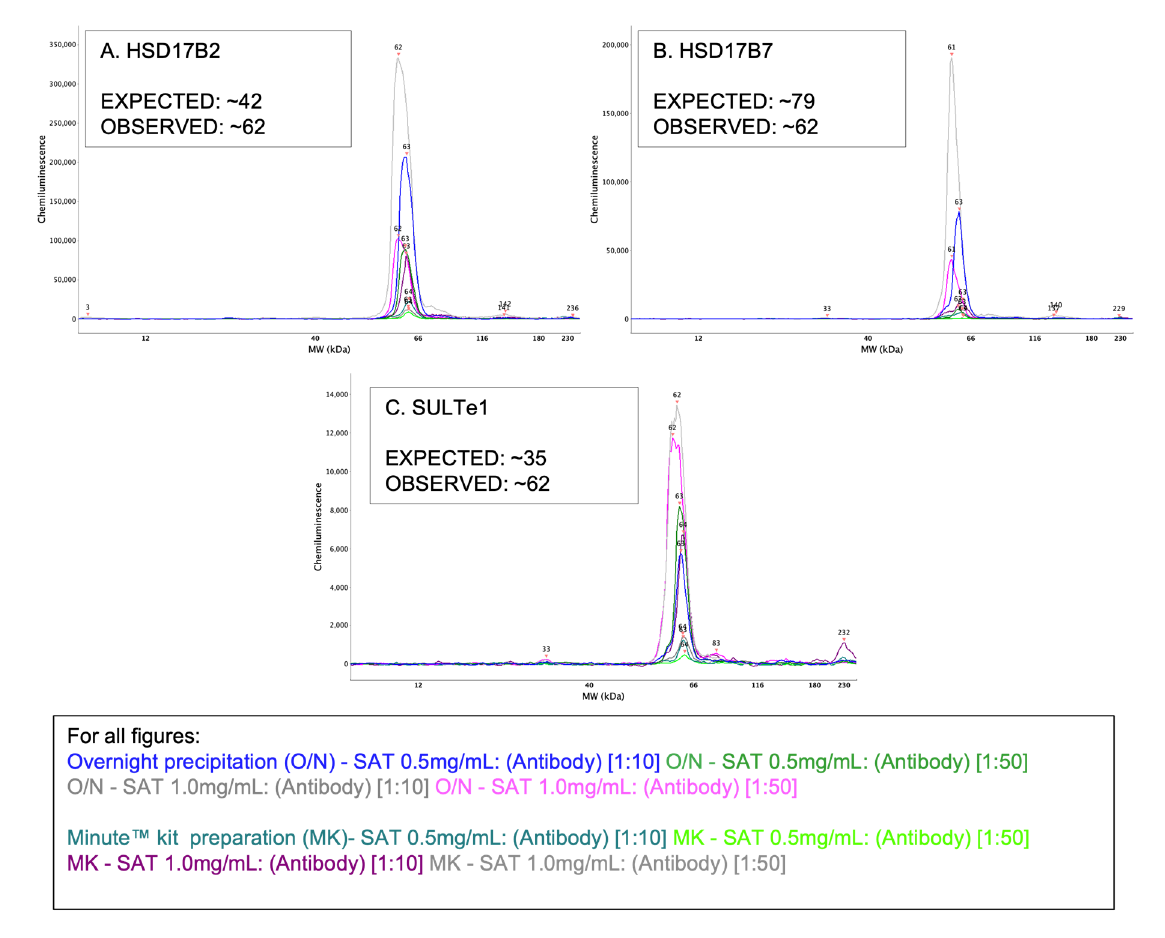
Figure 5. Each electropherogram compares results from overnight acetone precipitation and Minute™ kit preparation of SAT samples. Lysate concentrations of 0.5 and 1.0 mg/mL paired with 1:10 and 1:50 antibody concentration were tested: ( A ) HSD17ß2 ( B ) HSD17ß7 and ( C )